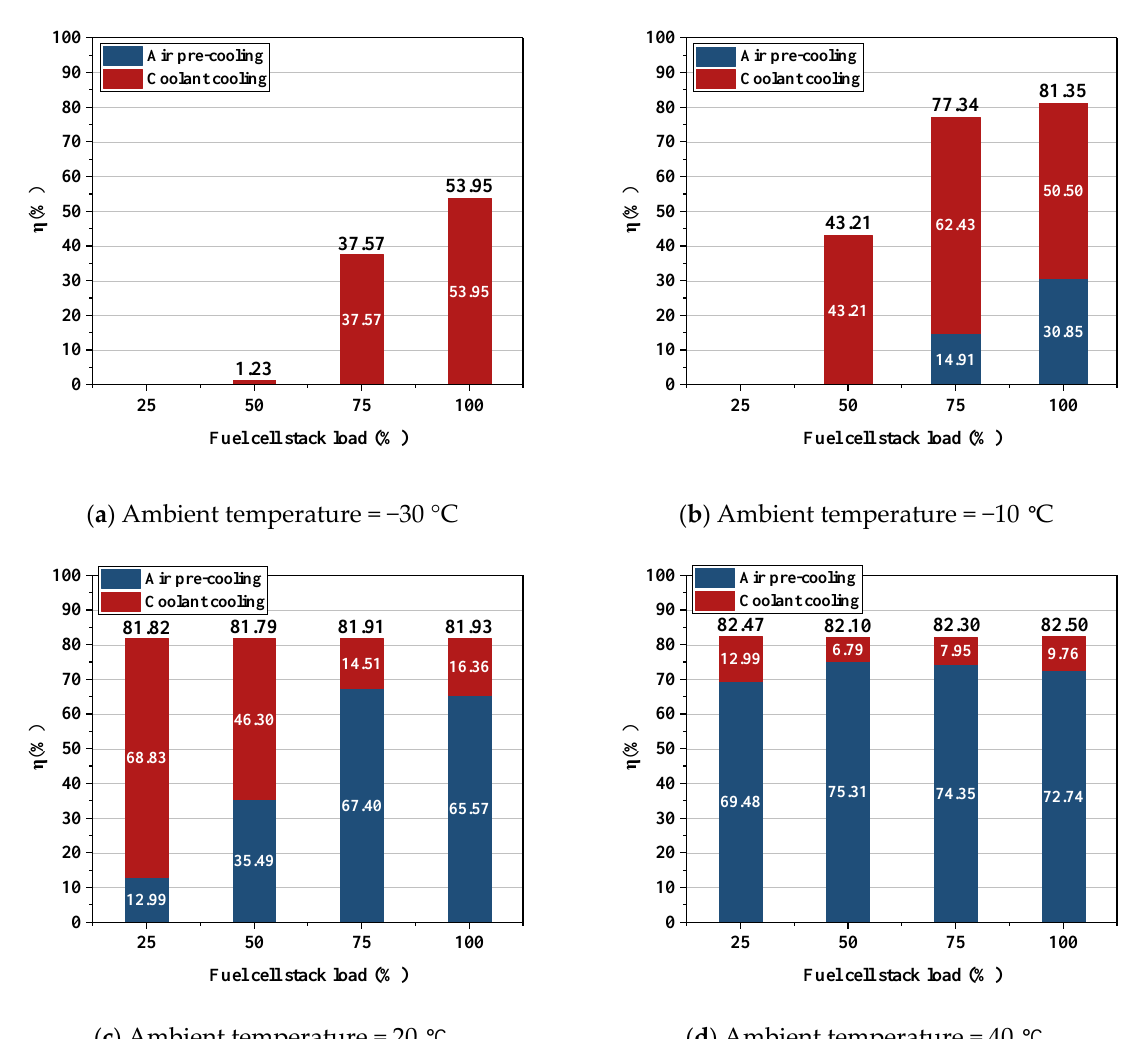
Figure 9. LH 2 cold energy utilization ratio. ( a ) Ambient temperature = −30 °C; ( b ) Ambient temperature = −10 °C; ( c ) Ambient temperature = 20 °C; ( d ) Ambient temperature = 40 °C.